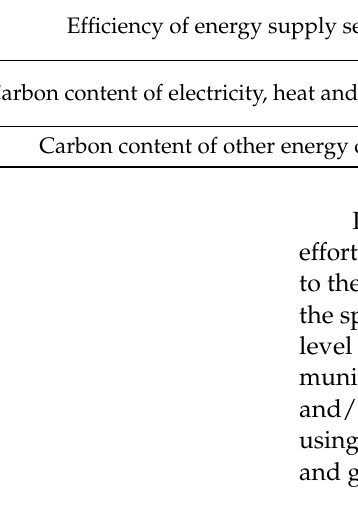
Table 4. Input data for the decomposition analysis of the municipality of Malmö with the identification of main sources and data geographical